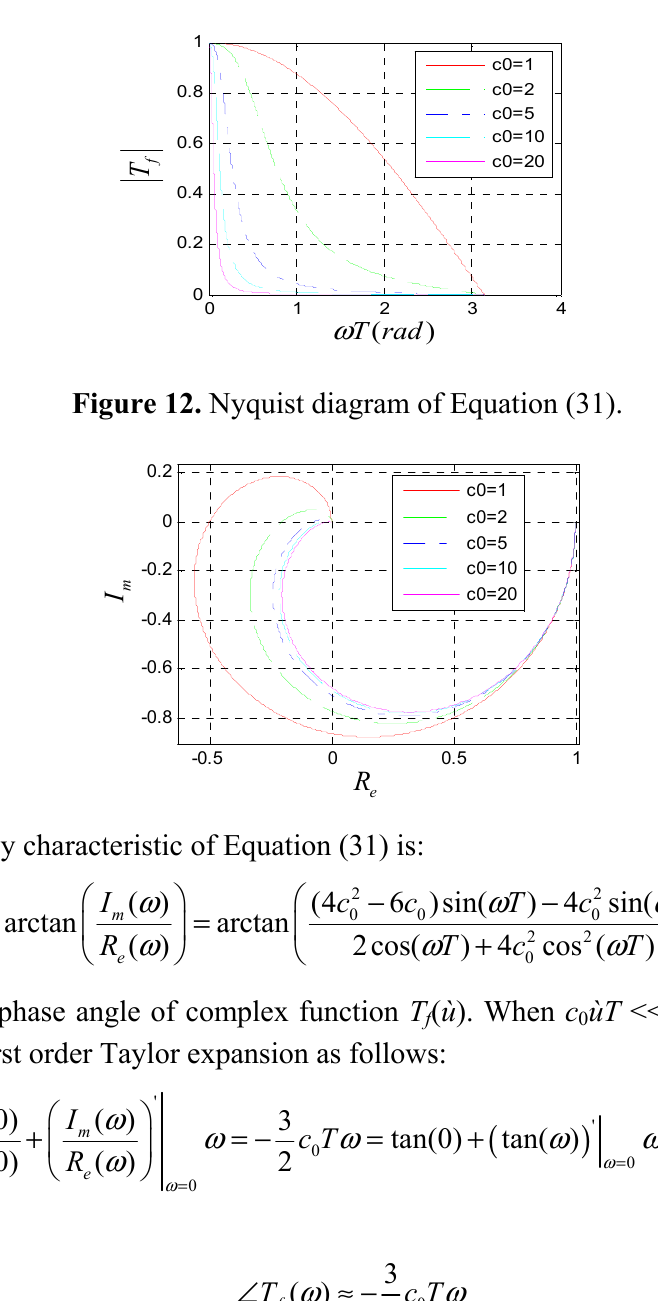
Figure 11. Amplitude-frequency characteristic of Equation (31).